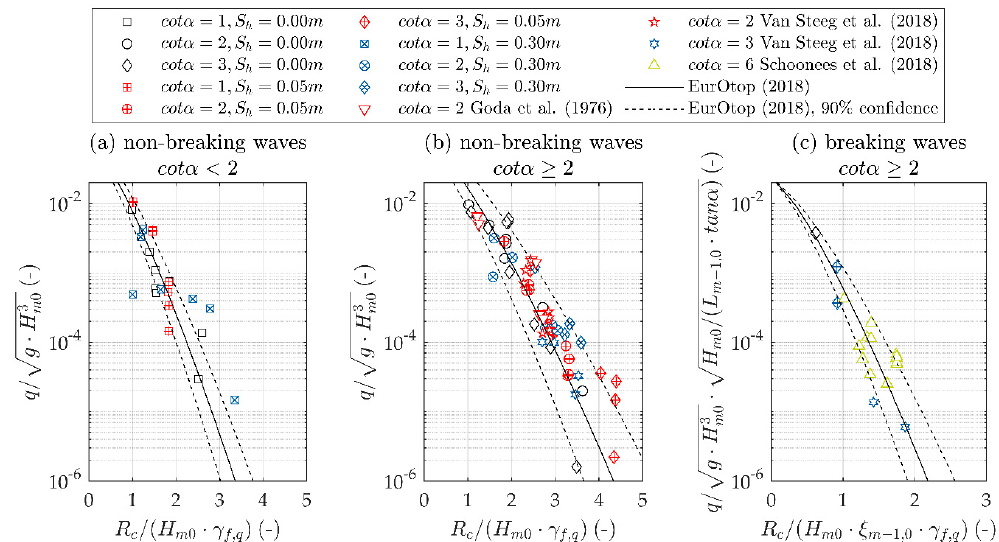
Figure 4. Dimensionless overtopping discharge against the dimensionless freeboard height including a roughness coefficient for stepped revetments. Overtopping prediction formulae according to EurOtop (2018) [13] are given for smooth slopes and 90% confidence bands. Data for ( a ) steep slopes with 𝑐𝑜𝑡𝛼 < 2 and non-breaking wave conditions, ( b ) milder slopes with 𝑐𝑜𝑡𝛼 ≥ 2 and non-breaking wave conditions and ( c ) mild slopes with 𝑐𝑜𝑡𝛼 ≥ 2 and breaking wave conditions.